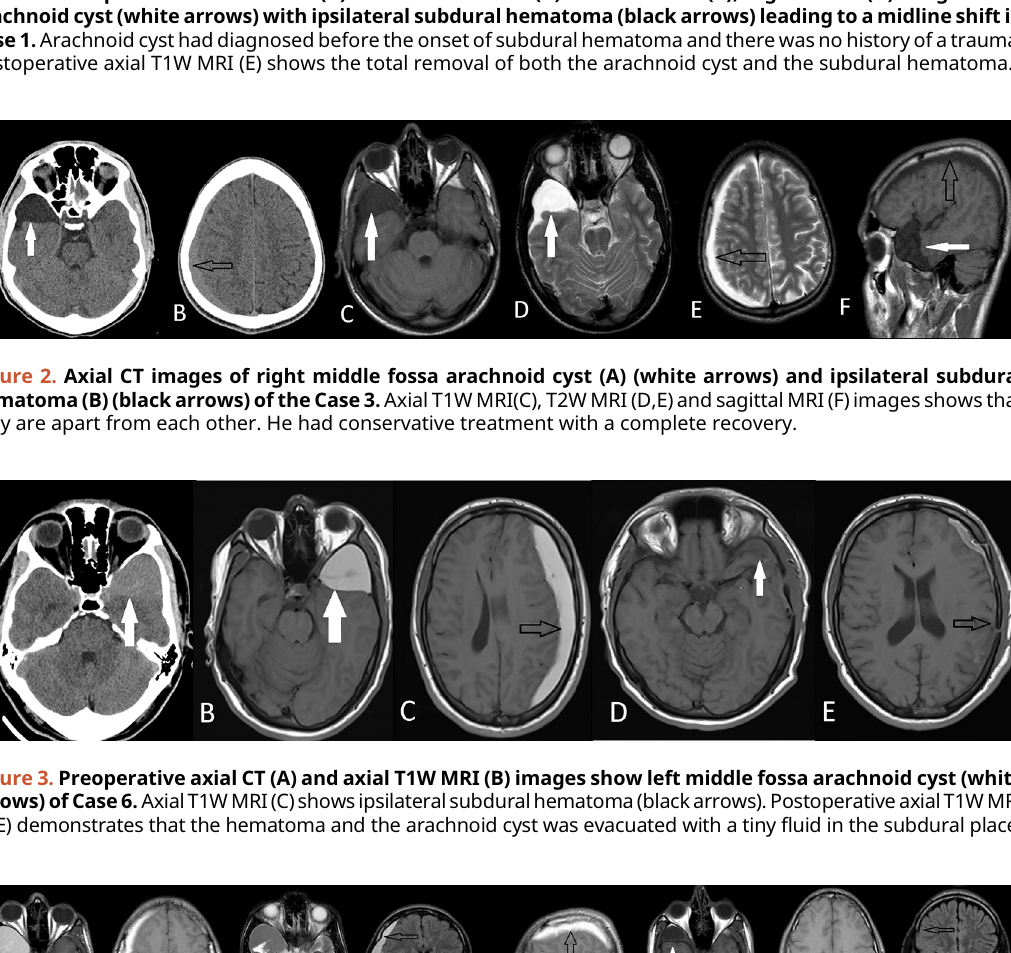
Figure 1. Preoperative axial CT scan (A) and axial T1W MRI (B) axial T2W MRI (C), sagittal MRI (D) images of an arachnoid cyst (white arrows) with ipsilateral subdural hematoma (black arrows) leading to a midline shift in